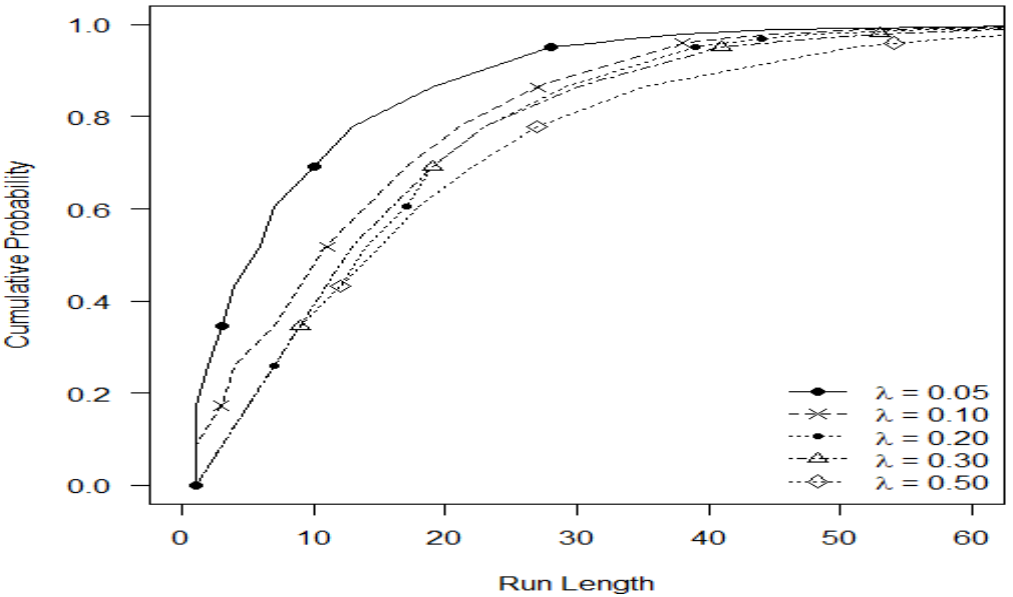
Figure 2. Run-length (RL) curves for different levels of 𝜆 when 𝑛 = 5 and 𝛿 𝑡 = 1.2.